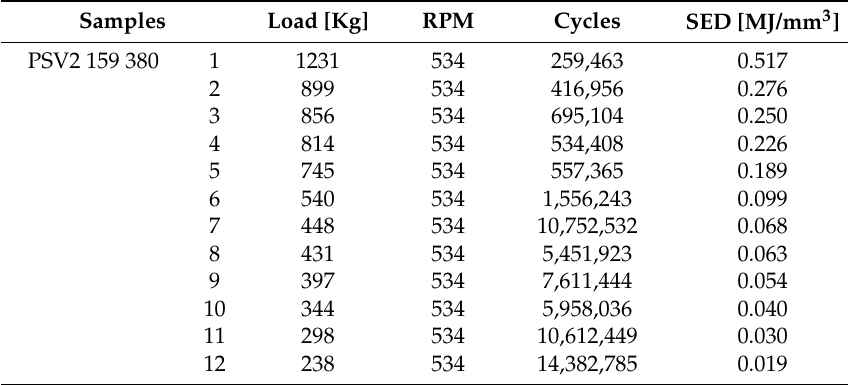
Table 4. Fatigue data for the roller PSV2 159